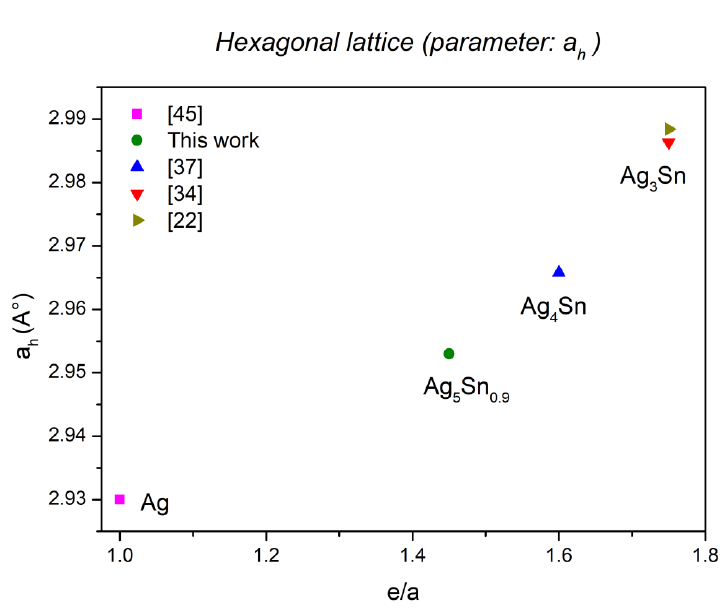
Figure 8. Evolution of the parameter a h as function of